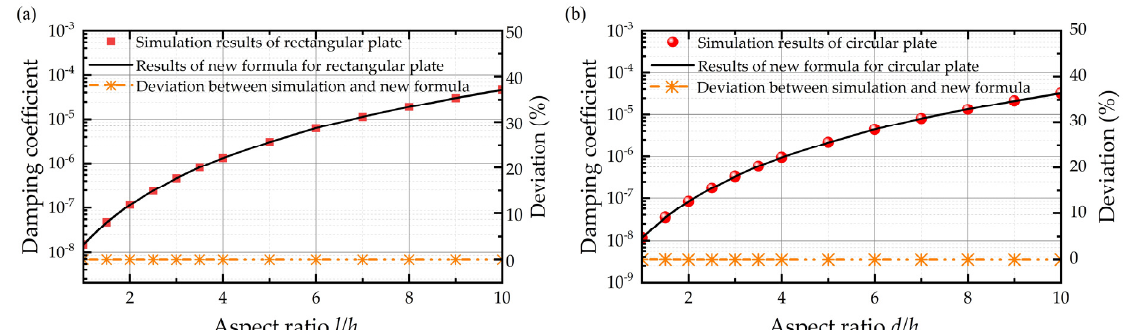
Figure 6. Fitting curve of deviations between the simulation results and theoretical results along with the residue of the fitting curve when the air film thickness is 0.6 mm for the ( a ) rectangular plate and ( b ) circular plate.